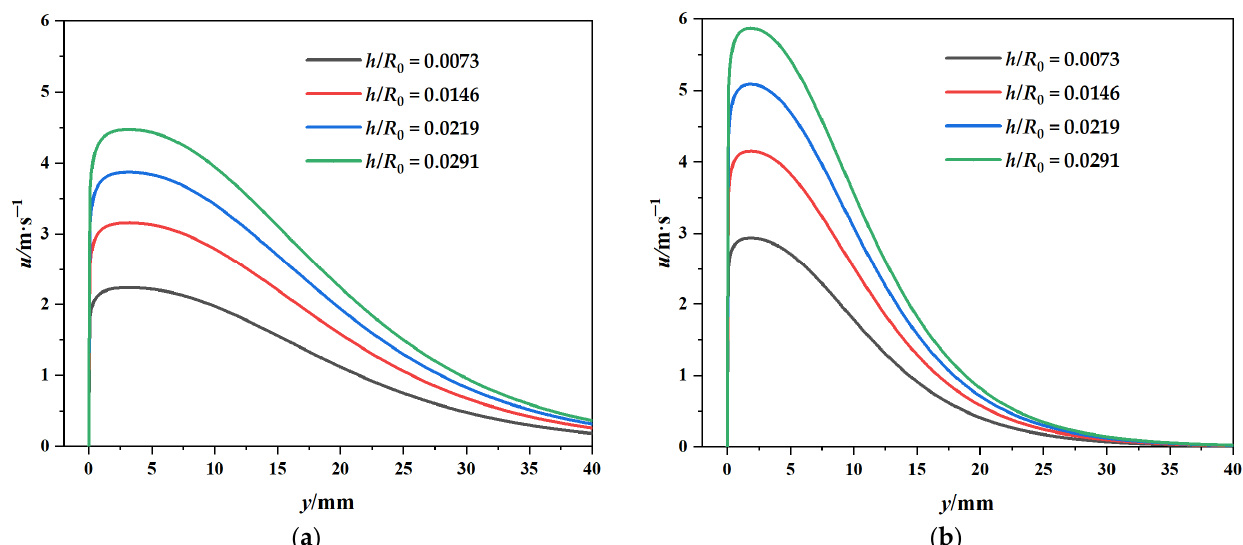
Figure 11. Velocity distribution with different h/R 0 over logarithmic spiral wall surfaces at ( a ) x / R = 1 and ( b ) x / R = 2/3.